Question: What kind of plot is shown here?
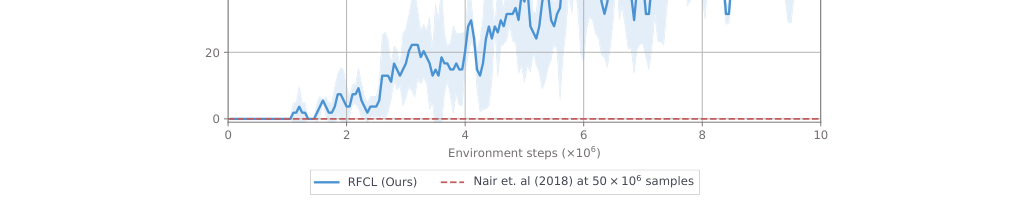
Answer: line